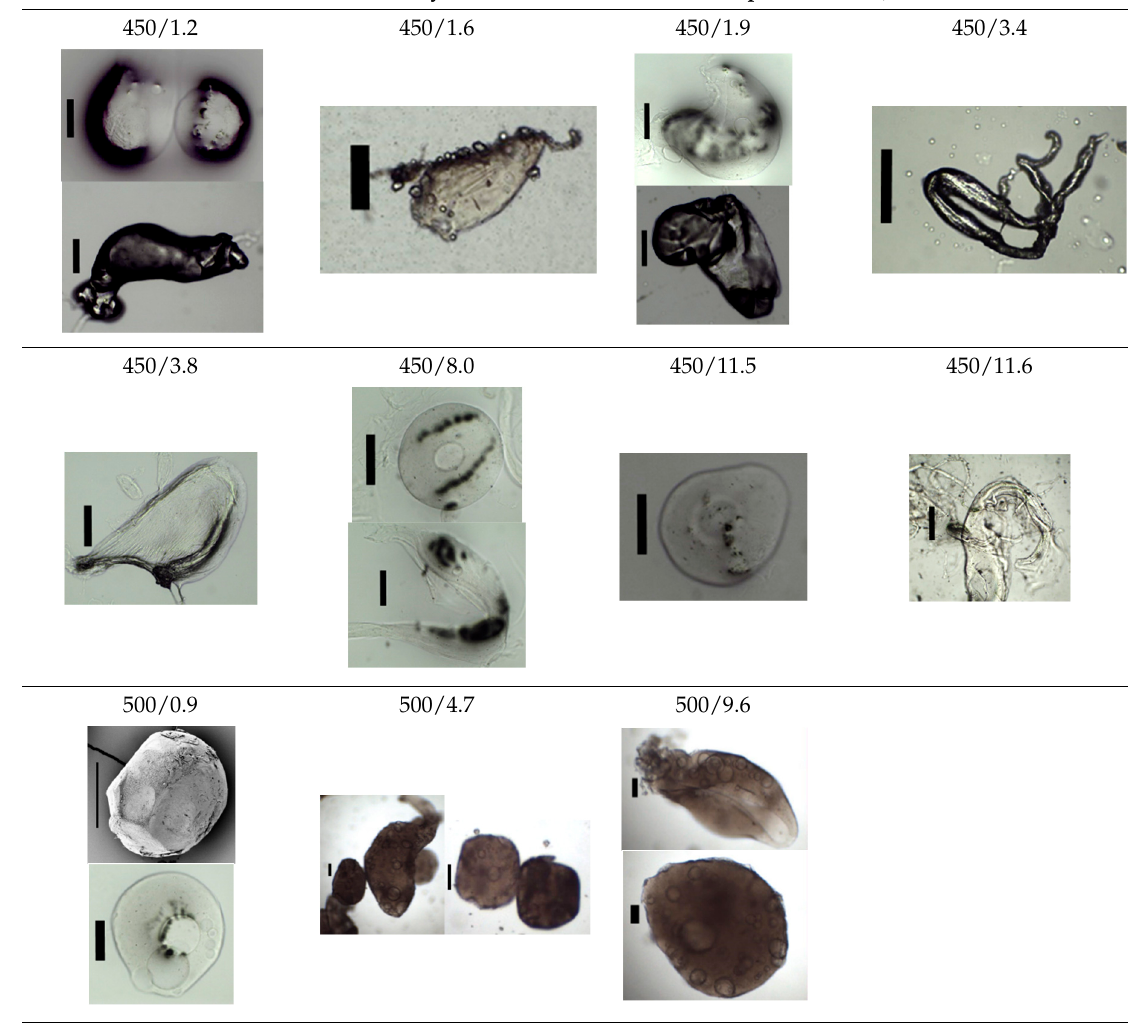
Table 4. Used nozzle diameters and cylinder ratios and obtained gel particles via the internal setting method.